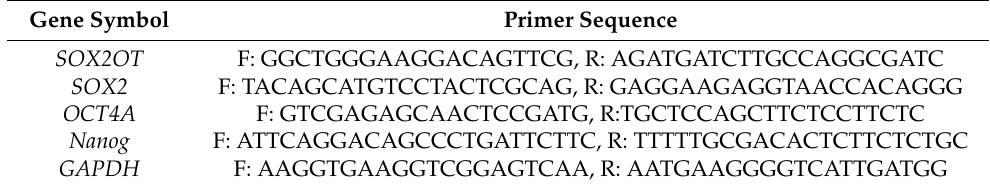
Table 1. Specific primers sequence of the target